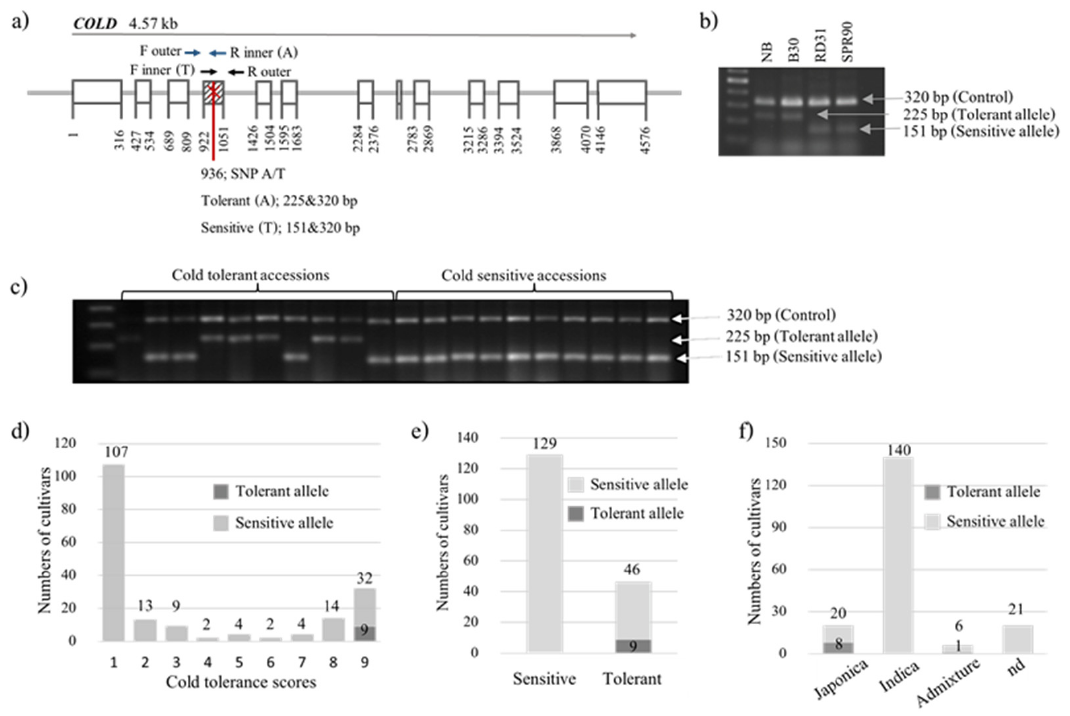
Figure 3. Mutation in COLD1 and its marker used for genotyping. ( a ) Structure of COLD1 showing polymorphic sequences between japonica (Nipponbare) and indica (9311). ( b ) Validation of the genotypic assay for two cold-tolerant (NB and B30) and two cold-sensitive (RD31 and SPR90) reference cultivars. ( c ) Representative examples of genotyping ten cultivars scored as cold-sensitive and ten cultivars scored as cold-tolerant among 187 accessions. ( d ) Allele frequency of COLD1 distributed in 1–9 cold tolerant scores of 187 rice accessions. ( e ) Allele frequency of COLD1 in extremely tolerant (score 8,9) and extremely sensitive (score 1–3) rice accessions. ( f ) The distribution of tolerant and sensitive alleles of COLD1 in each subspecies